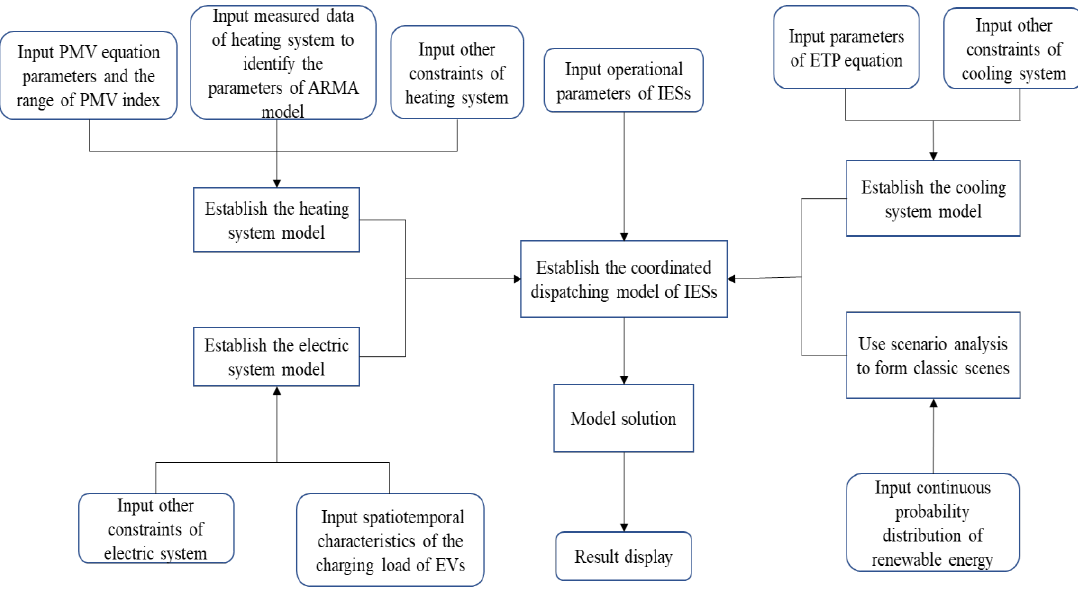
Figure 5. The process of the optimization algorithm.